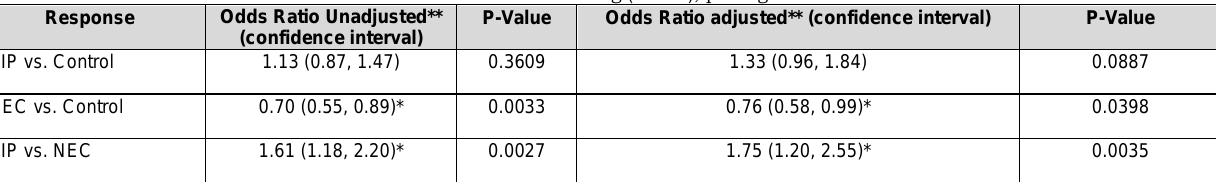
Table 2. Association of baseline log (NRBC), per log unit increase Response